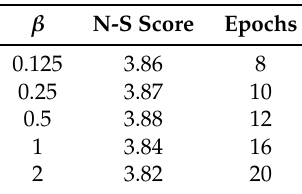
Table 1. Impact of balance factor β on retrieval accuracy and convergence speed. The experiment is conducted on UKBench with VGGNet-16, and retrieval accuracy is measured by N-S Score. Convergence speed is measured by the number of epochs to reach the best retrieval accuracy. β